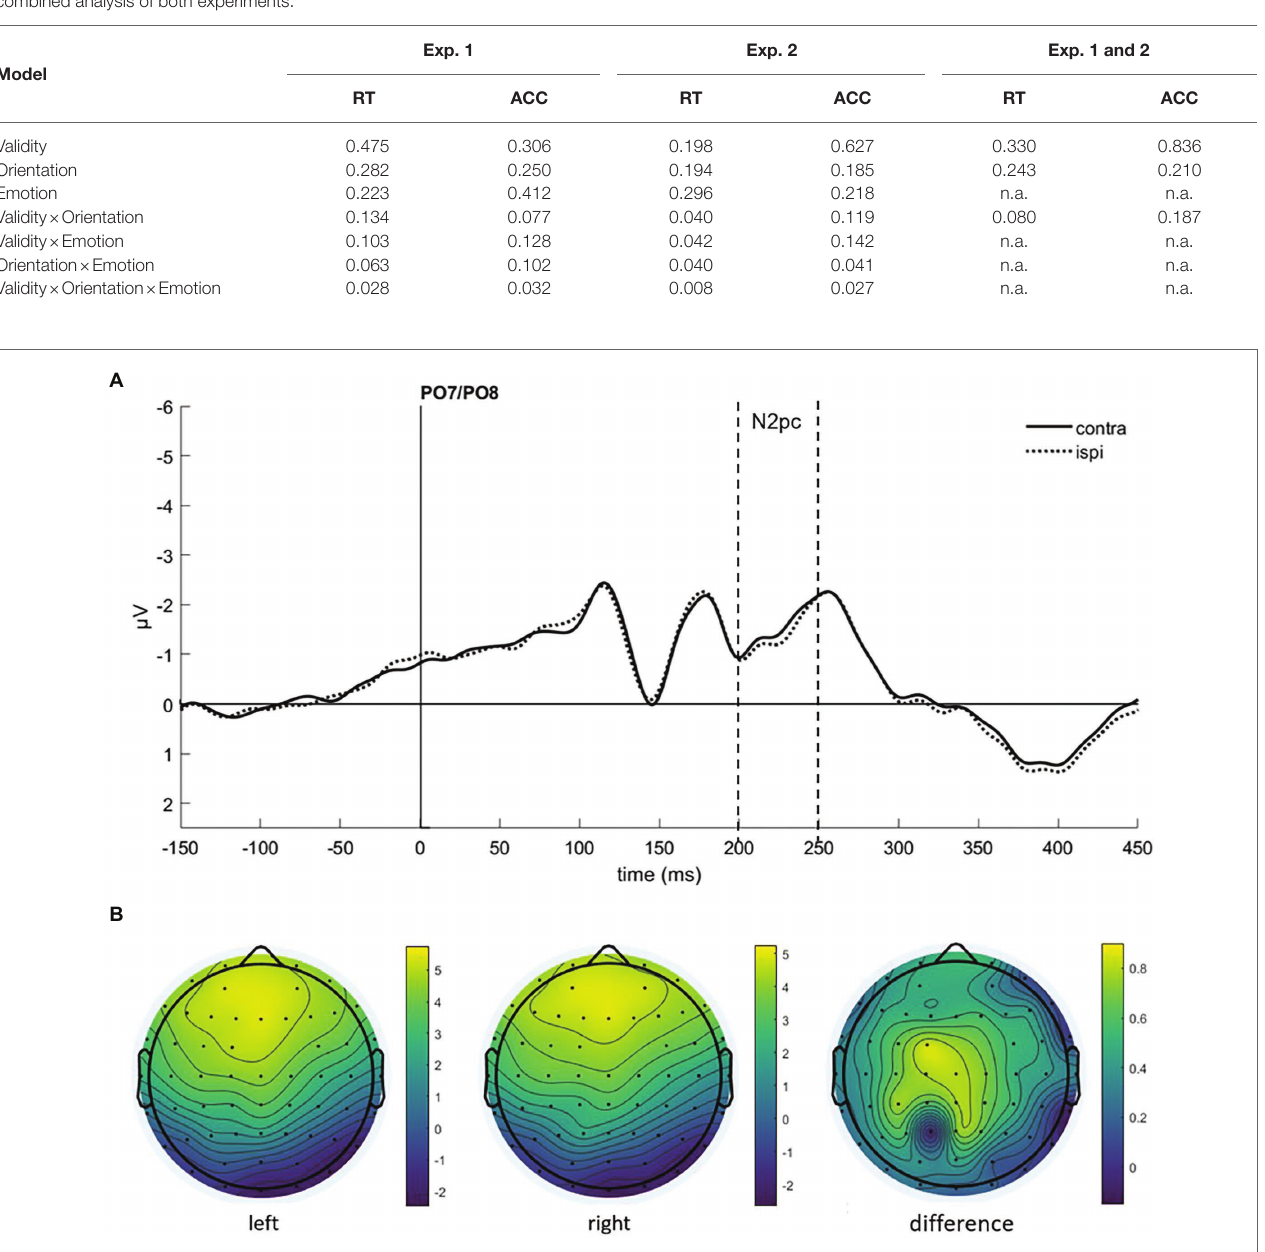
FIGURE 6 | (A) Event-related potentials (ERPs) in Experiment 2 after cue onset collapsed over experimental conditions. Activity contralateral to the fearful emotional cue is represented by a solid line, ipsilateral by a dotted line. (B) Scalp topographies for left/right cue presentation and difference (in μ V) averaged over 200–250 ms after cue onset